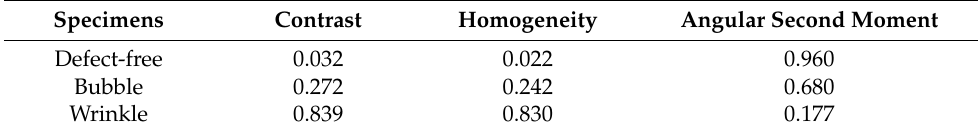
Figure 11. The texture patterns of the original images of carbon fiber plain-woven prepreg with and without defects, corresponding to Figure 4. Table 3. The mean value of textural features.